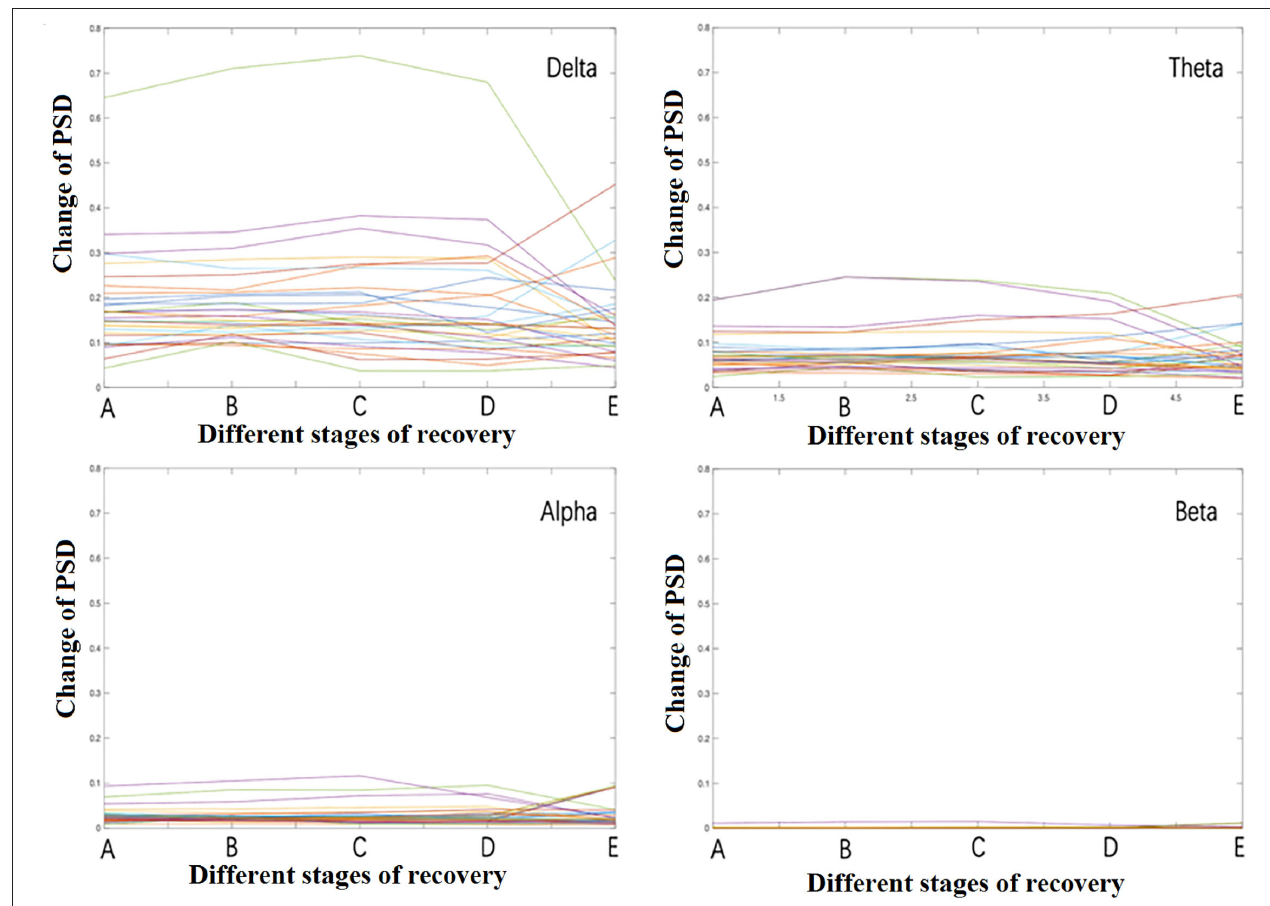
FIGURE 3 | The overall change of PSD in the different frequency band.